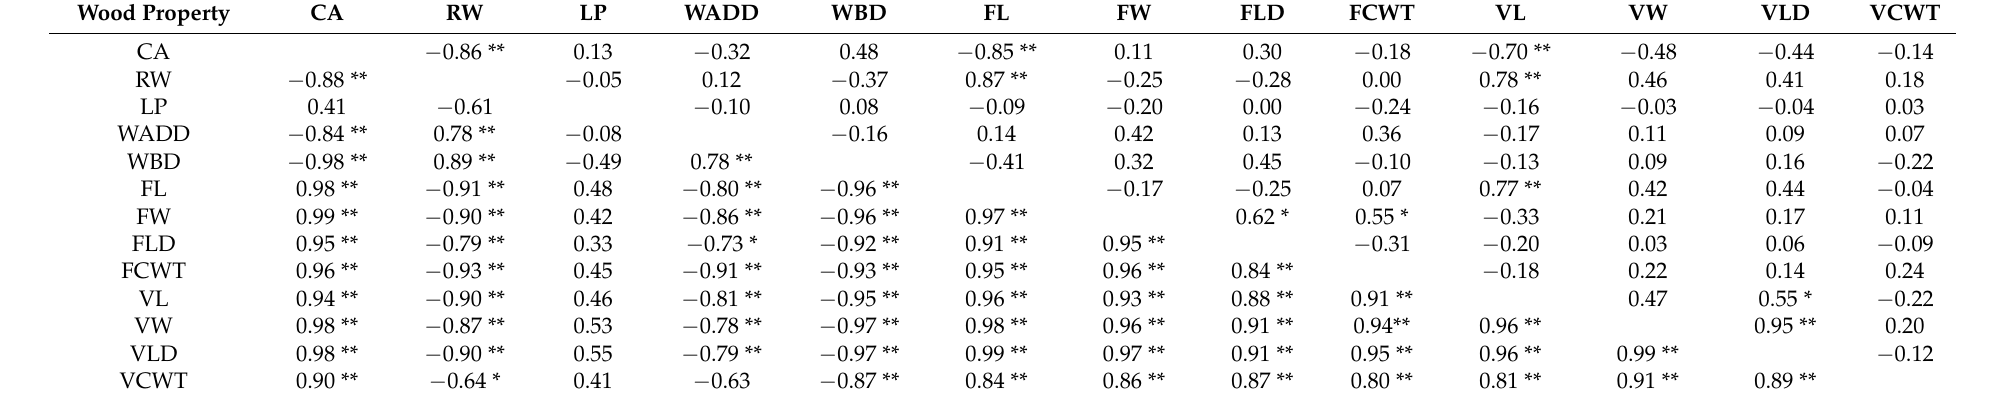
Table 4. Correlation analysis among different wood properties in the first 20 years and after 20